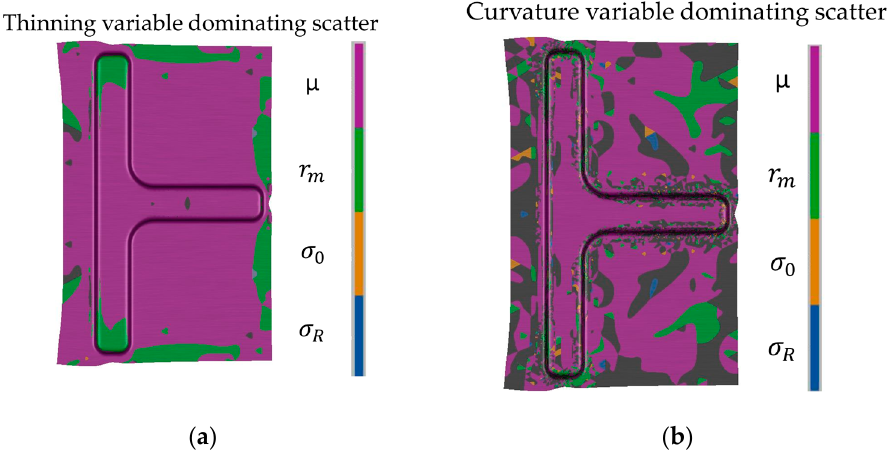
Figure 14. Noise parameter with the largest influence on the ( a ) thinning and ( b ) curvature.